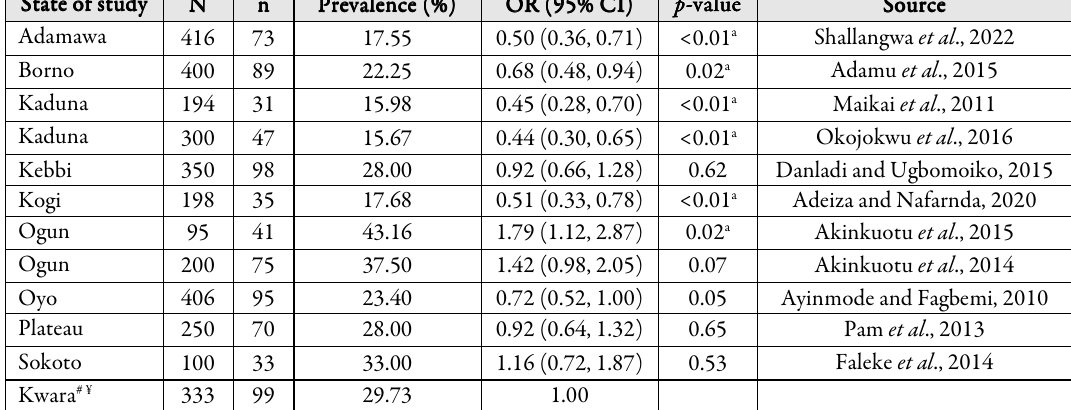
Table 1. The prevalence of Cryptosporidium species among cattle in Kwara State and other states in Nigeria State of study N